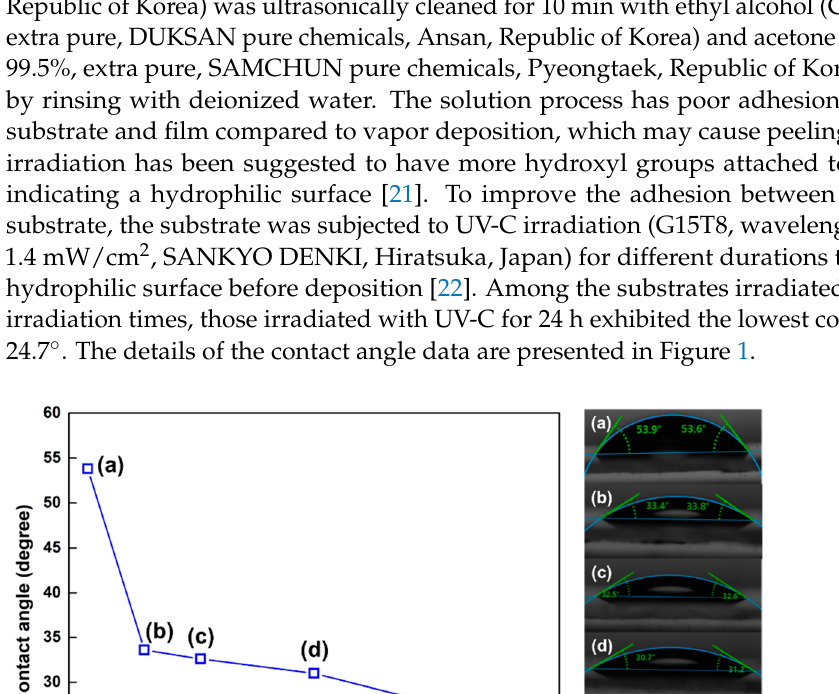
trate hydrate (Ga(NO 3 ) 3 ∙ xH 2 O, 99.9% pure, supplied by Alfa Aesar, Seoul, Republic of Ko ‐